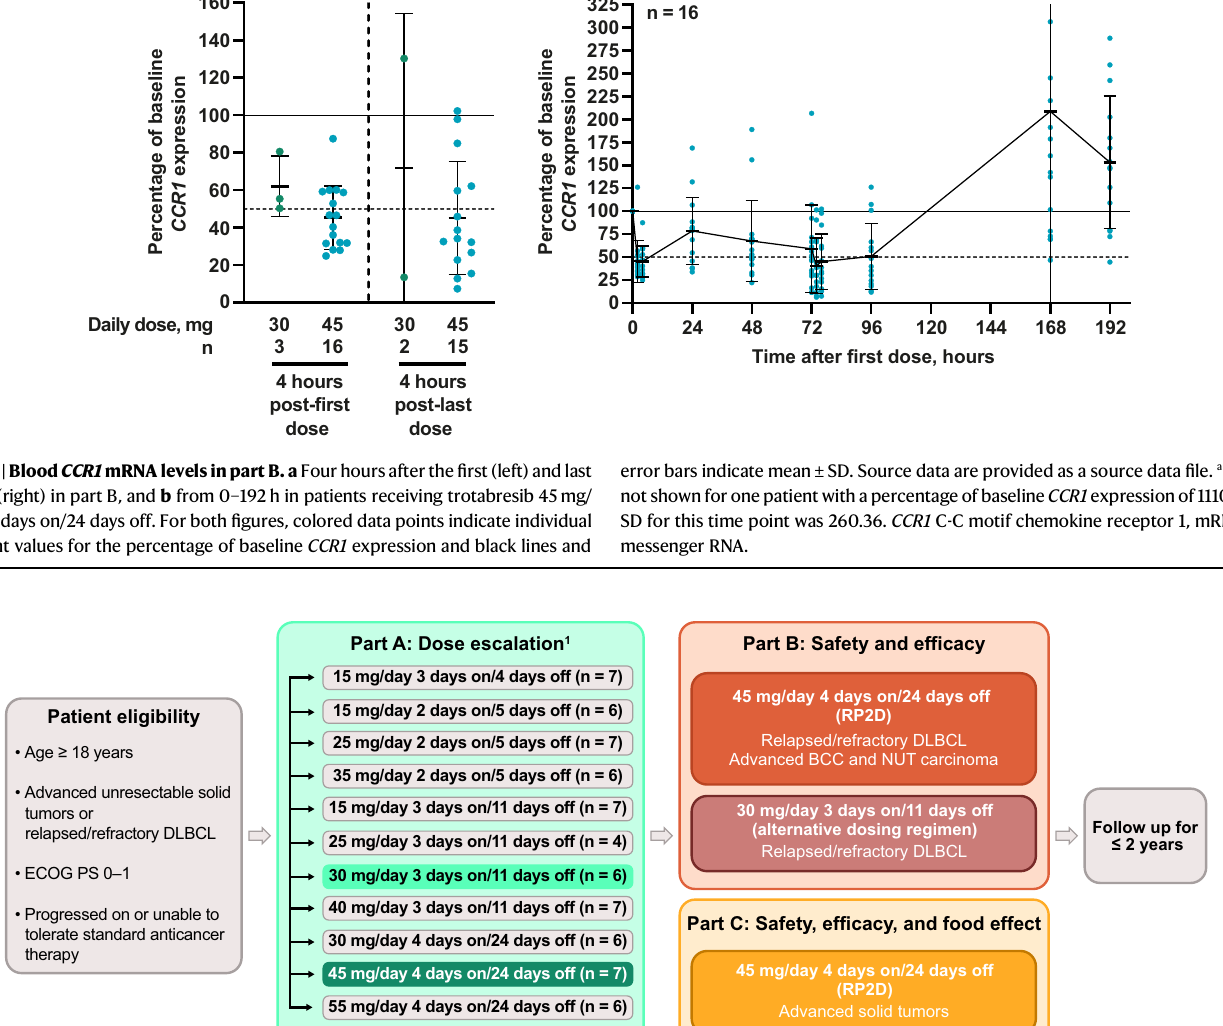
Fig. 7 | Study design. BCC basal cell carcinoma, DLBCL diffuse large B-cell lymphoma, ECOG PS Eastern Cooperative Oncology Group performance status, RP2D recommended phase II